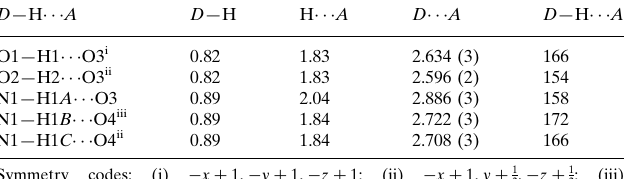
Hydrogen-bond geometry (A˚ , (cid:3)